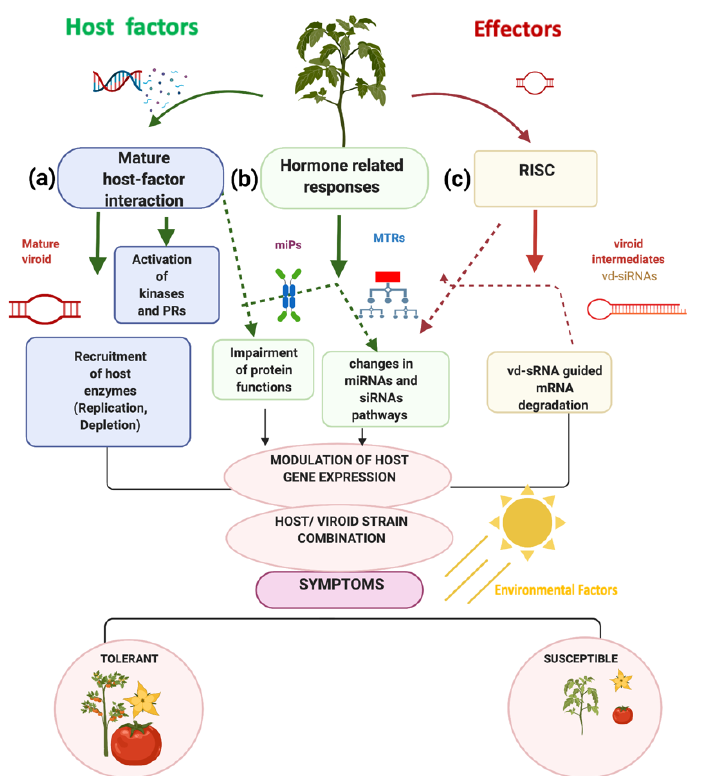
Figure 8. Proposed mechanism of viroid-host interplay. Symptom development is an outcome of the complex plant-pathogen interaction as a result of alterations to cell processes related to viroid RNA-mediated genetic regulation. Host factors: ( a ) description of the putative interplay of mature viroid and host factors, in which the activation of signaling and plant defense response events via kinases and pathogen related proteins (PRs) takes place, and viroid replication requires the recruitment of host enzymes; ( b ) plant hormone-related responses trigger impairment of protein functions and changes in miRNAs and siRNAs pathways; ( c ) role of viroid-derived interfering small RNAs (vd-siRNAs) that guide mRNA degradation. Dotted arrows indicate the putative links among the different RNA-mediated regulation processes. Illustration created with